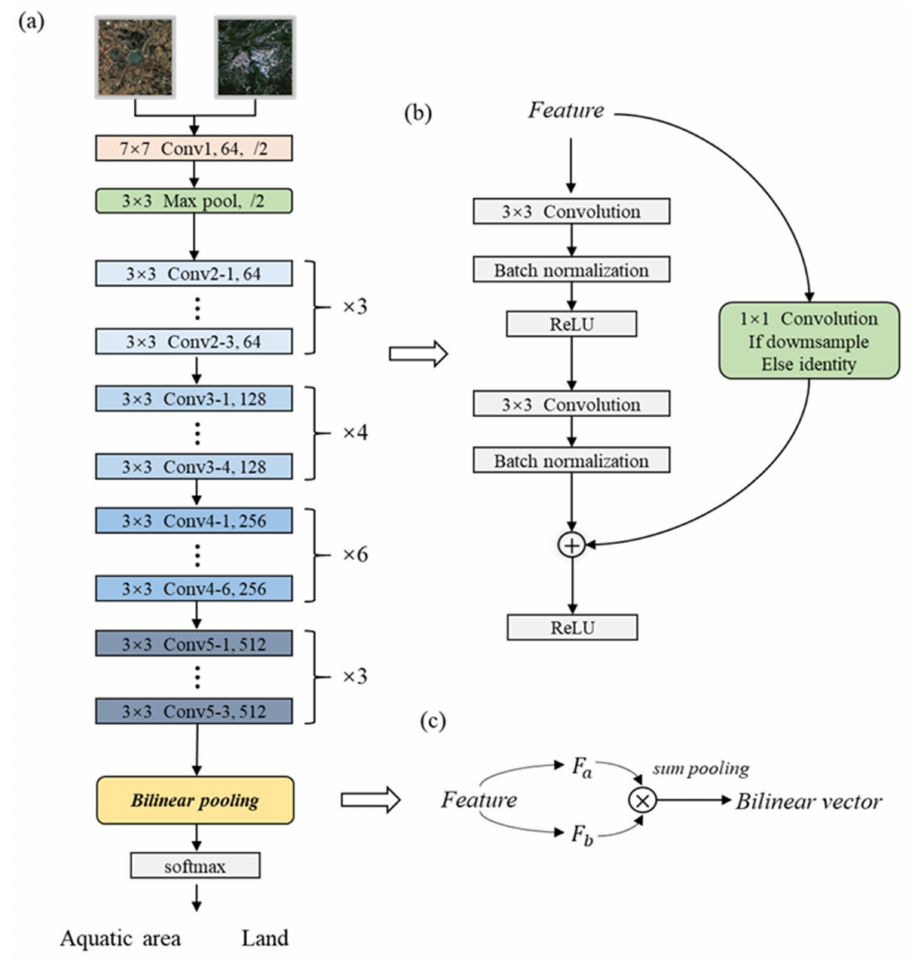
Figure 9. The architecture of Bilinear CNN for first-stage coarse-classification task: ( a ) The network structures of ResNet 34; ( b ) The basic residual block of ResNet 34; ( c ) Bilinear pooling